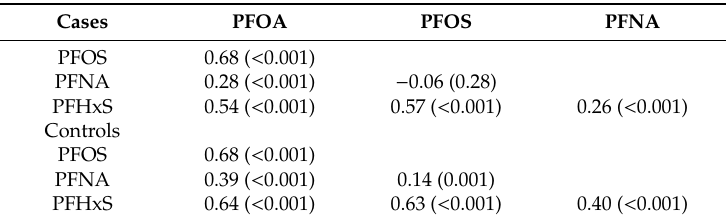
Table 2. Spearman correlation coe ffi cients (with p -values in parentheses) between the di ff erent PFAS compounds a in early pregnancy among 296 preeclampsia cases and 580